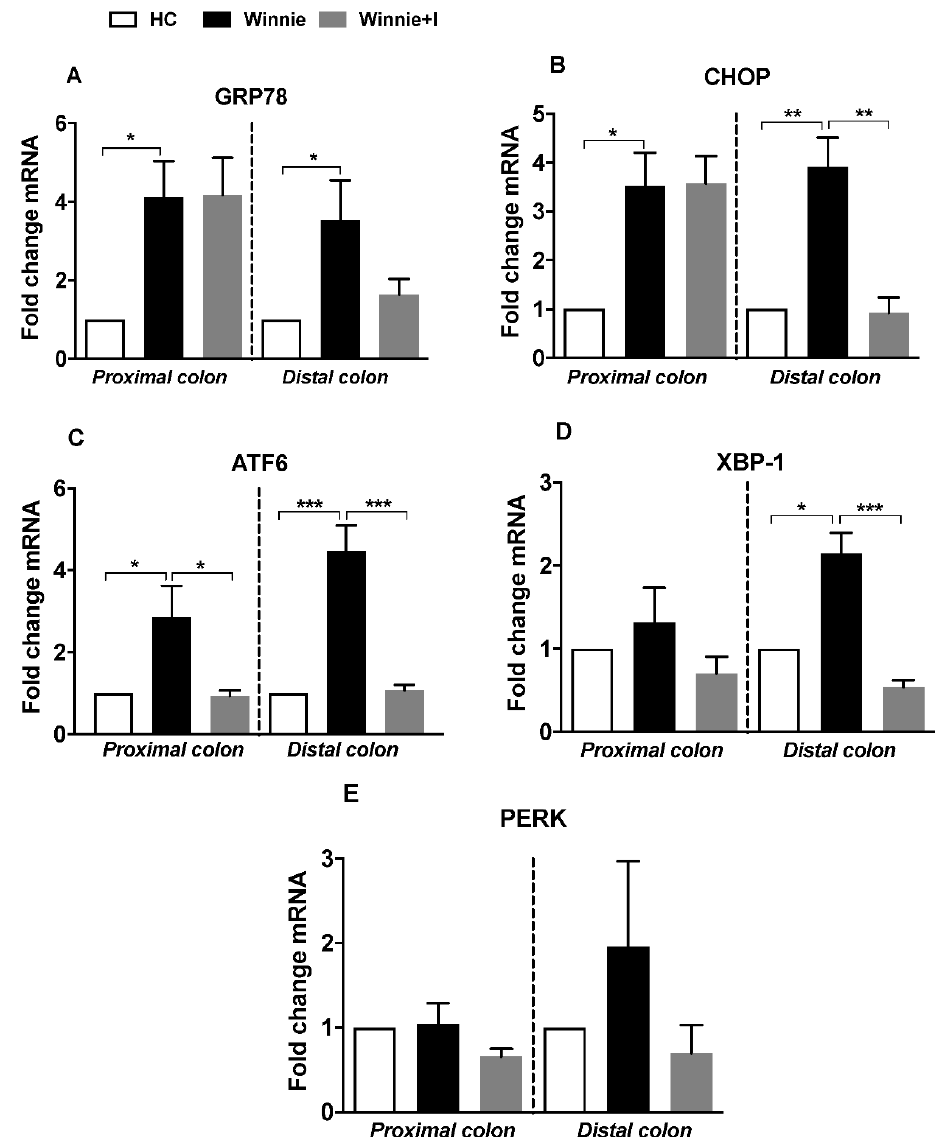
Figure 4. E ff ect of idebenone on mRNA levels of endoplasmic reticulum stress (ER stress) markers in the Winnie model of spontaneous chronic colitis. Gene expression of ( A ) GRP78 , ( B ) CHOP , ( C ) ATF6 , ( D ) XBP-1 and ( E ) PERK were determined for the proximal (PC) and distal colon (DC) for all the three groups. mRNA levels were normalized to GAPDH gene and presented as fold change. Data represents mean ± SEM ( n = 4 / group) using One-way ANOVA followed by Tukey’s post-test, where * p < 0.05, ** p < 0.01 and *** p <